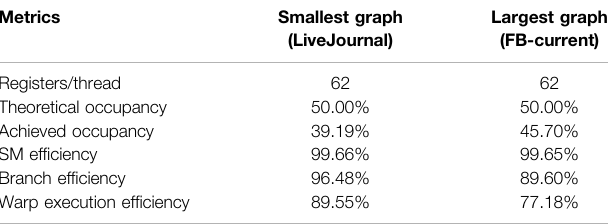
TABLE 4 | Performance metrics of the kernels using the NVIDIA Pro fi ler nvprof.